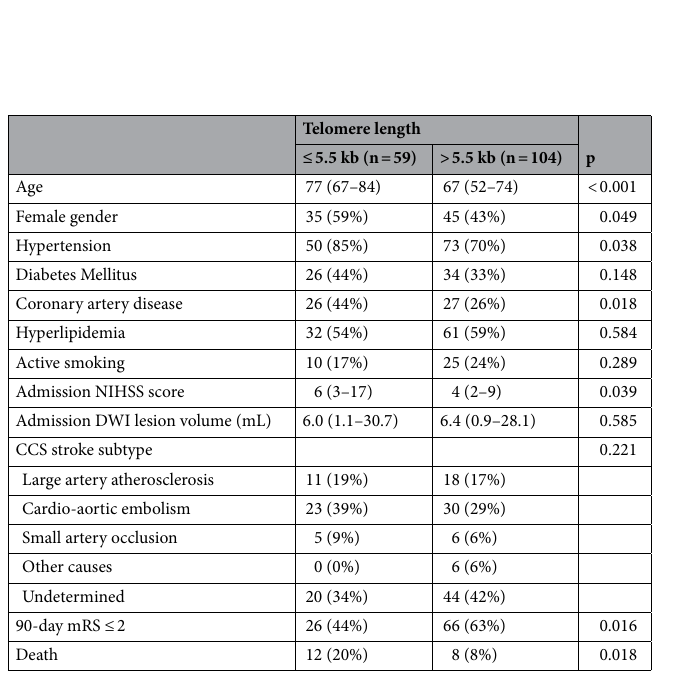
Table 2. Clinical features of ischemic stroke patients stratified according to telomere